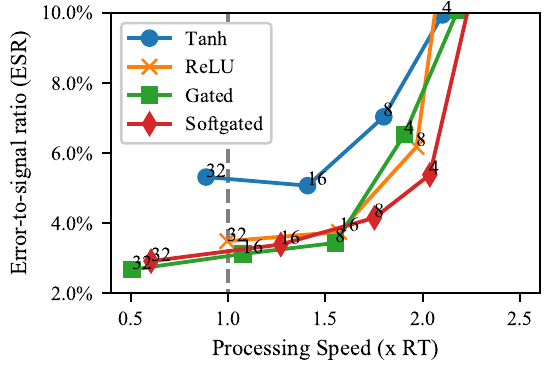
Figure 7. The validation error-to-signal ratio (ESR) as a function of processing speed with different activation functions and different numbers of channels in the convolutional layers. The number of convolution channels used is indicated next to each model.